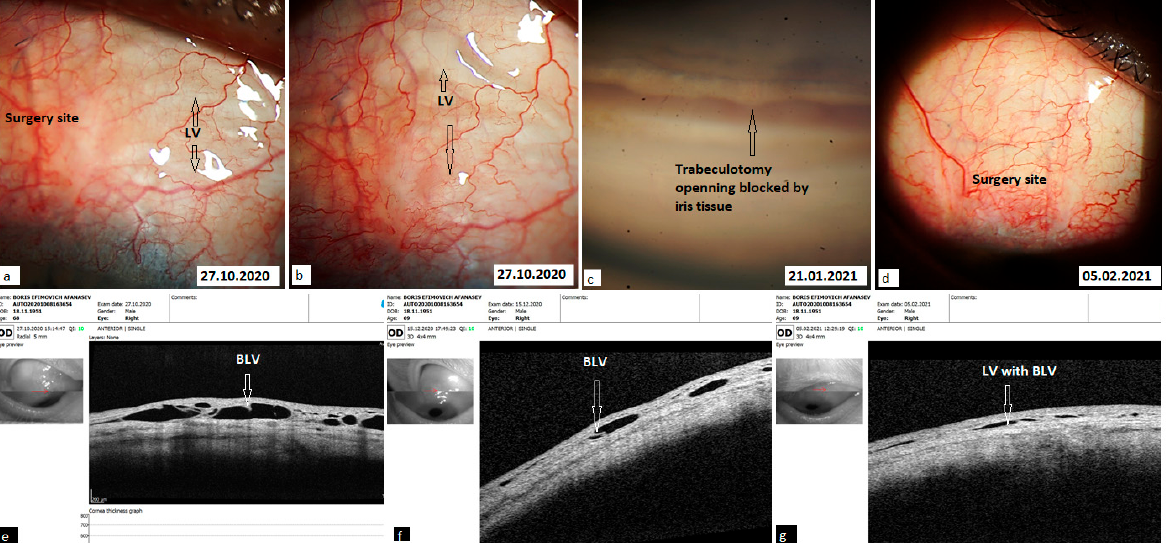
Figure 9. Conjunctival lymphatic plexus in the right eye of a male patient having undergone a combined procedure. An Nd:YAG laser trabeculotomy was performed seven days after surgery. ( a , b ) Clinical image of surgery site 2 weeks after trabeculotomy. Lymphatic vessels are filled with transparent fluid (black arrows). ( c ) After 3 months, the patient had an increase in IOP due to blockage of the trabeculotomy site by iris tissue (black arrow). A repeat trabeculotomy near to the blockage site lowered IOP below the target level and it remained this way for the rest of the follow-up period. ( d ) Image of the surgery site taken 4 months after the trabeculotomy showing absence of any bleb. ( e – g ) OCT scans identifying the lymphatic nature of vessels in the conjunctiva lying over the scleral flap and in the conjunctiva adjacent to the medial and lateral borders of the surgery site (white arrows). BLV = bicuspid lymphatic valves, IOP = intraocular pressure, LV = lymphatic vessels, OCT = optical coherence tomography.